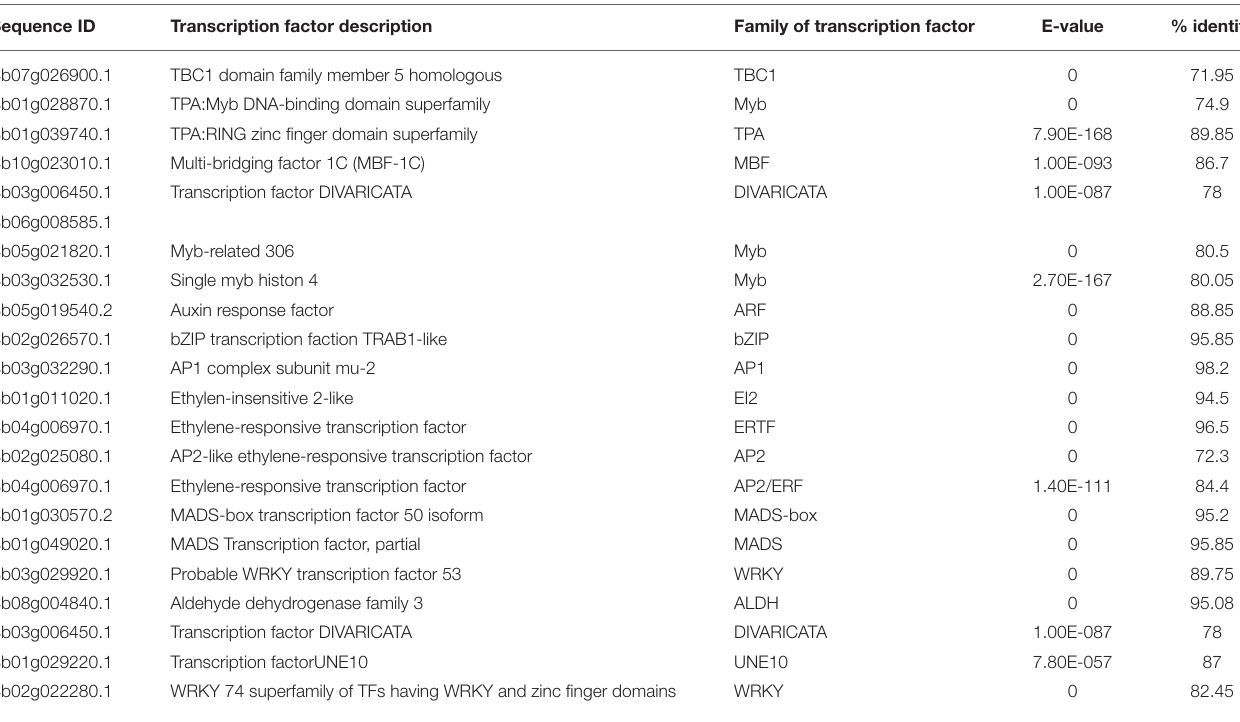
TABLE 4 | Transcription factor involved in drought-related